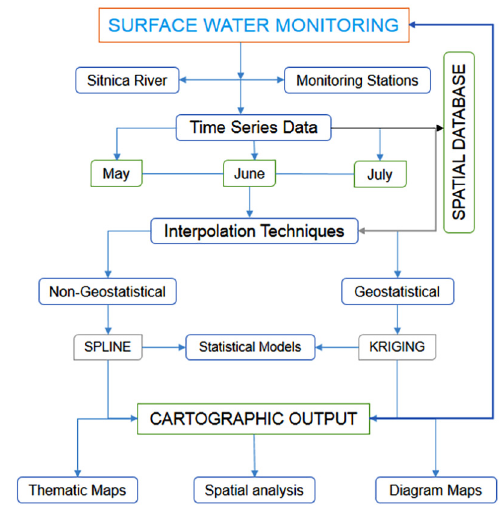
Figure 2. Workflow diagram